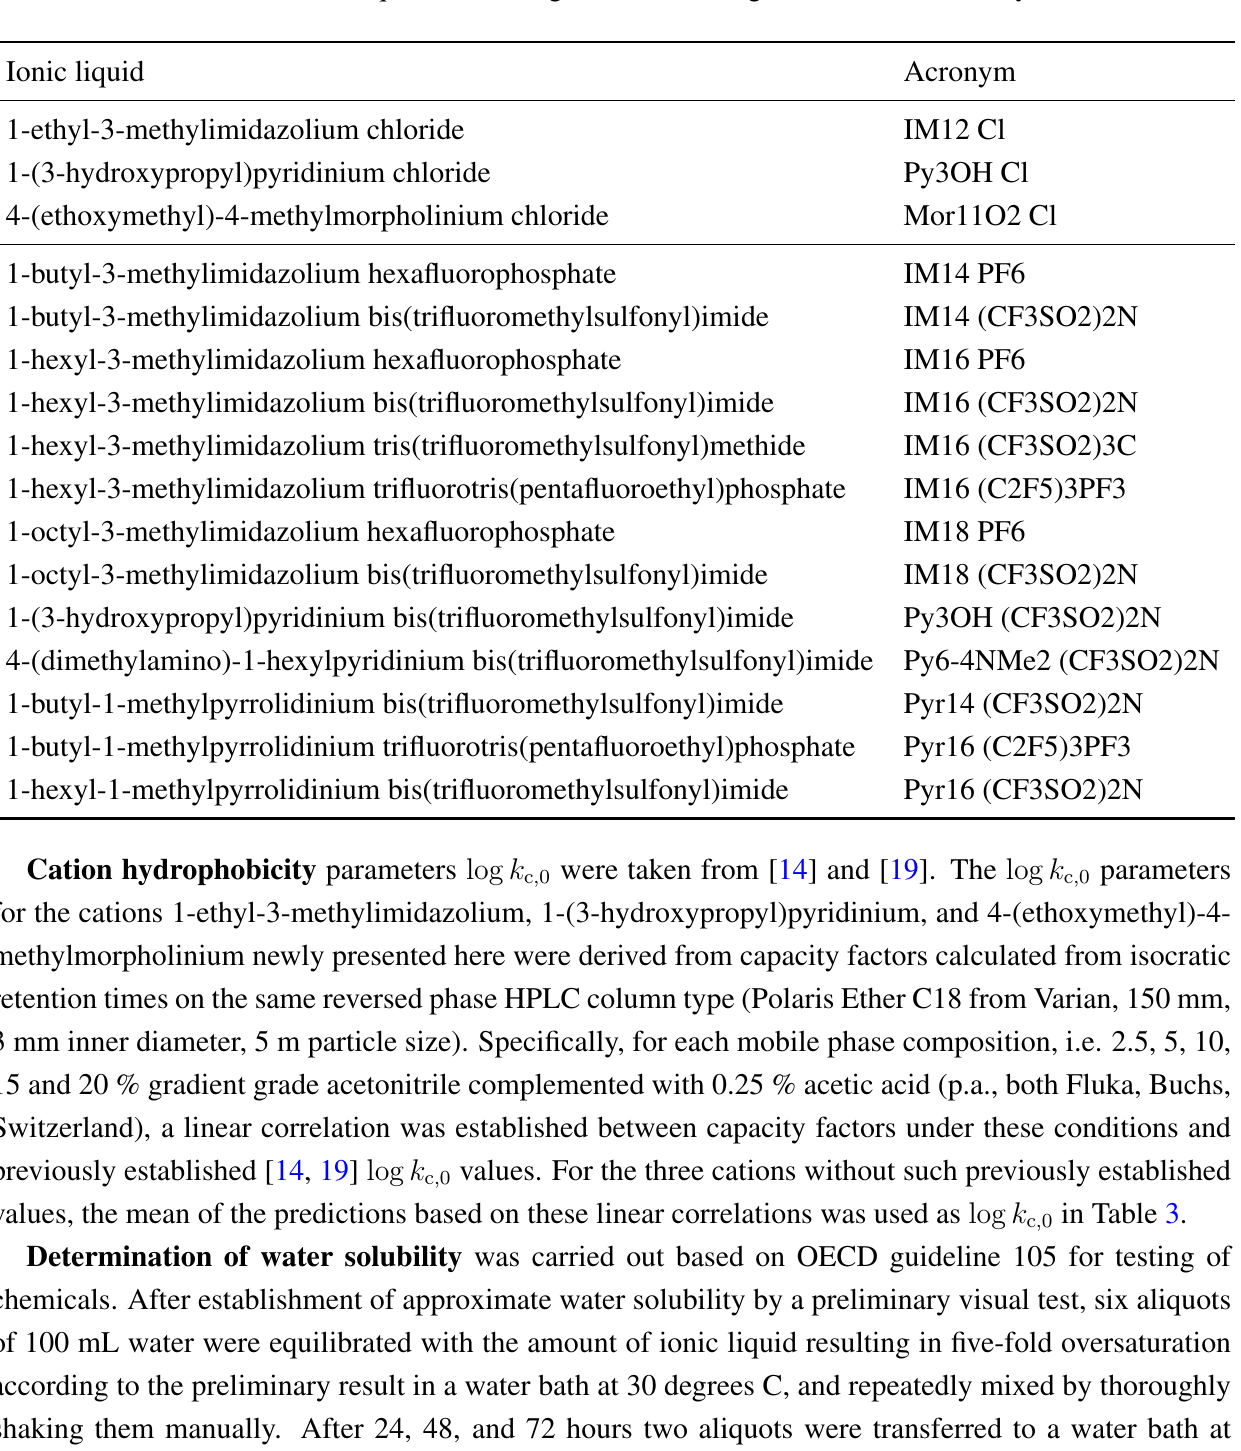
Table 2. Ionic liquids used for generation of original data for this